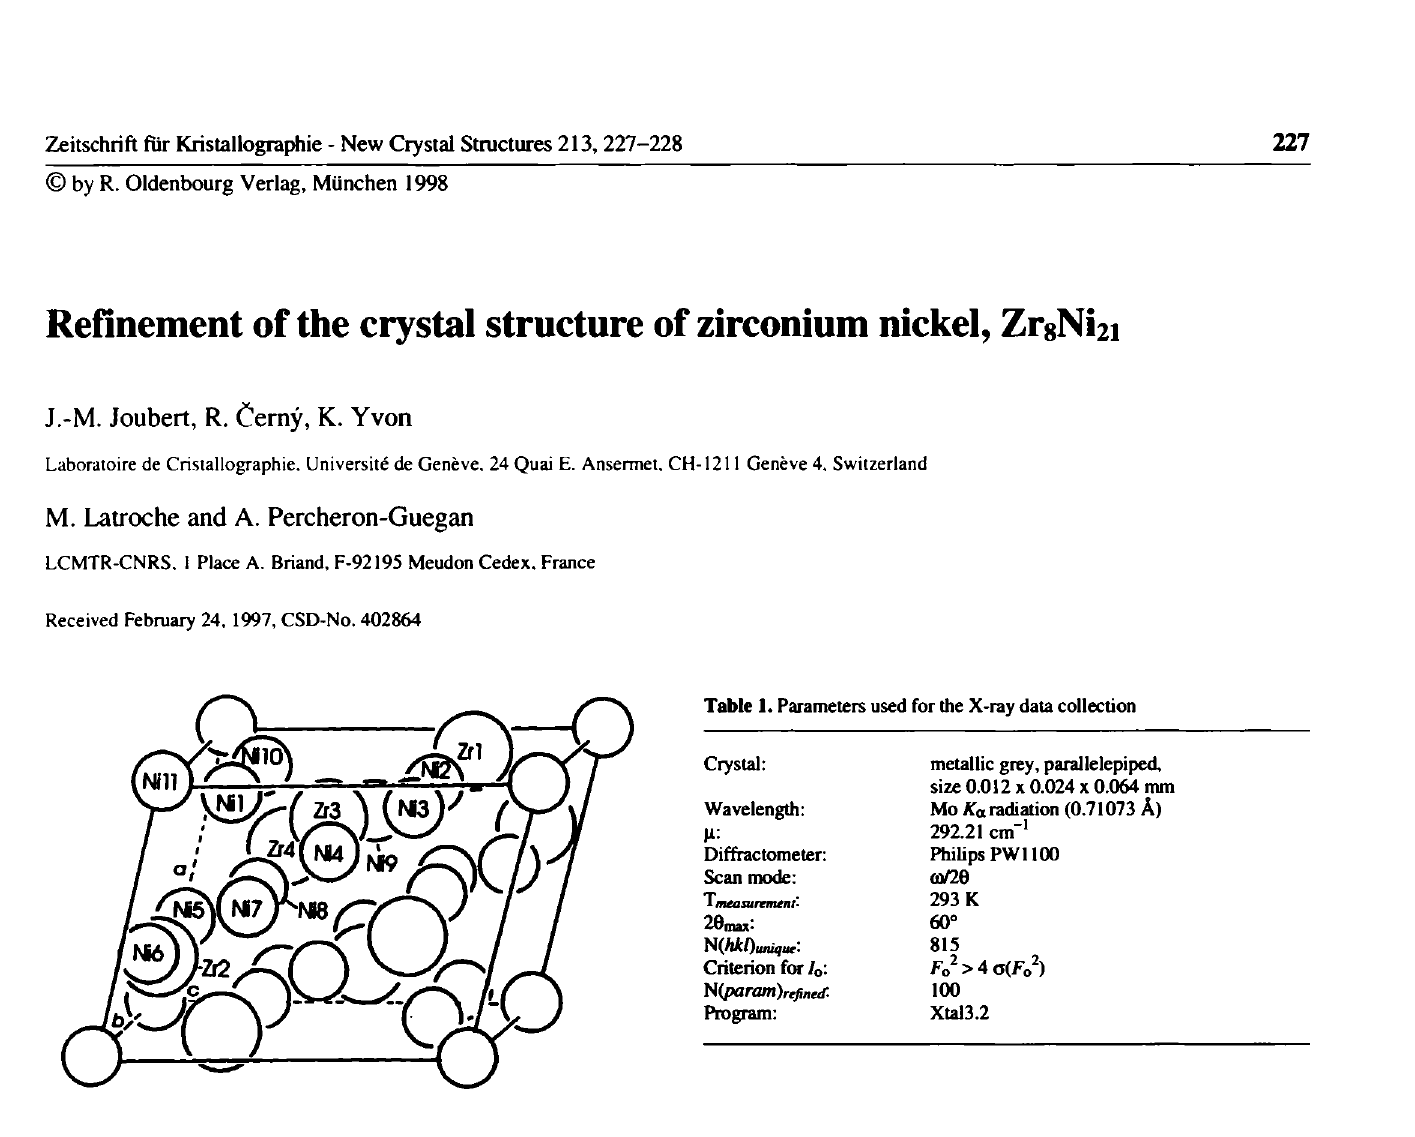
the isotypy with HfsNiai with refined positional parameters differences in the range 0.000-0.004 for each atooL The structure parameters are standardized by the program Structure Tidy (see ref. 3). The structural relations with the adjacent phase in the phase diagram ZrzNi? have already been discussed (see ref. 2). The interatomic distances between Zr and its nearest Ni neighbours (2.60 Â - 2.6S Â) are significantly shorter than the sum of the metallic radii (2.84 Â) thus indicating strong Zr-Ni interactions. The Ni-Ni distances (2.40 Â - 2.46 Â), and the Zr-Zr distances (3.15 Â -3.36 Â) are similar to the sum of metallic ladii (Ni-Ni: 2.48 Â; Zr-Zr: 3.20